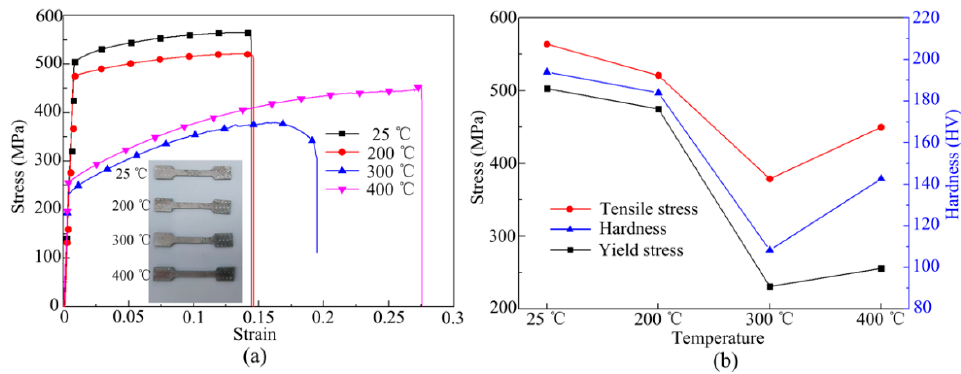
Figure 7. Mechanical properties of sheet metal after forming: ( a ) tensile curve; ( b ) stress and hardness curves.